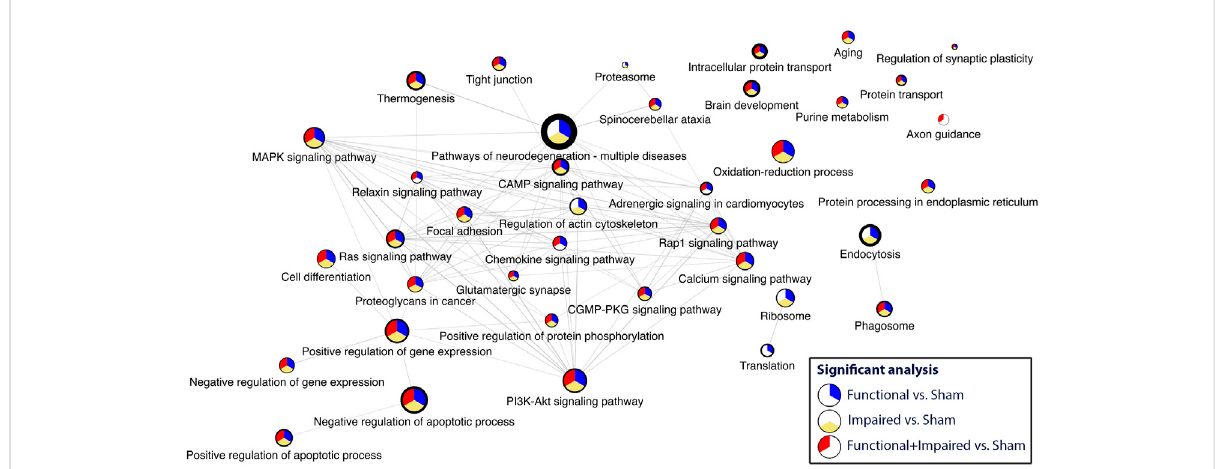
Consensuspathway analysisand visualization ofenrichedpathwayswith aGSEA < 0.5and aminimumoffour statistically signi fi cantproteinsper pathway. Higher enrichment is depicted through the border thickness. The colors blue, yellow, and red represent the signi fi cance of the three